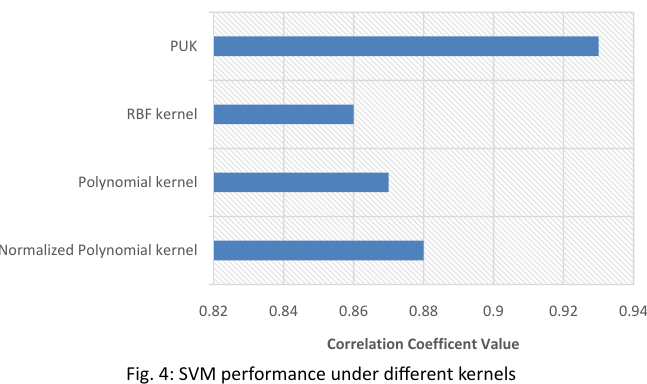
Fig. 4: SVM performance under different kernels Fig. 5: SVM performance under different kernels